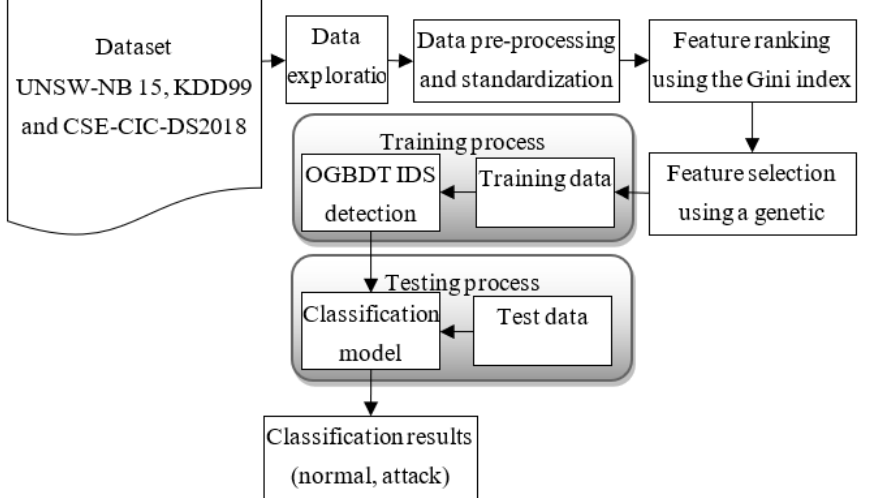
Figure 1. An optimized gradient boost decision trees-based IDSs model.